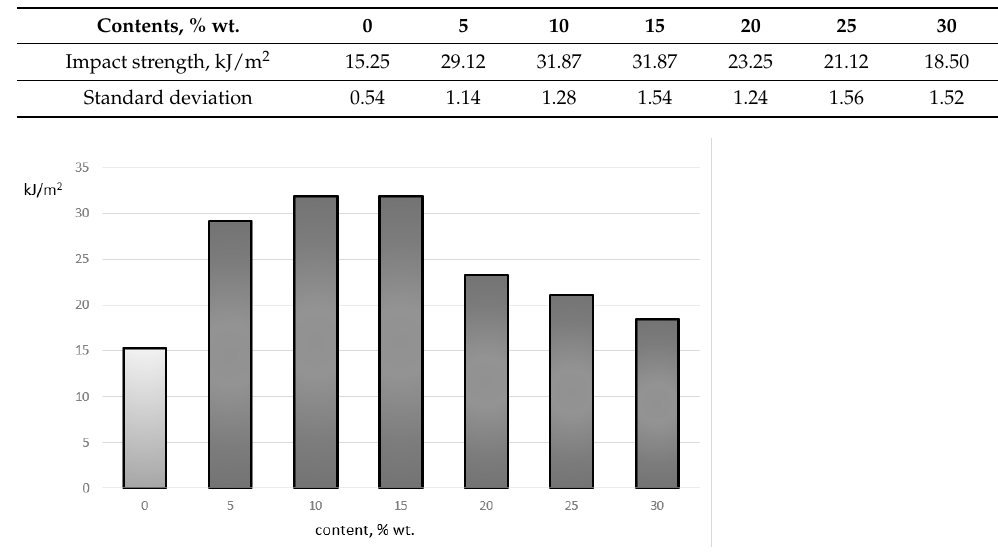
Figure 3. Change in impact strength depending on the content of the Crusil M20 filler.